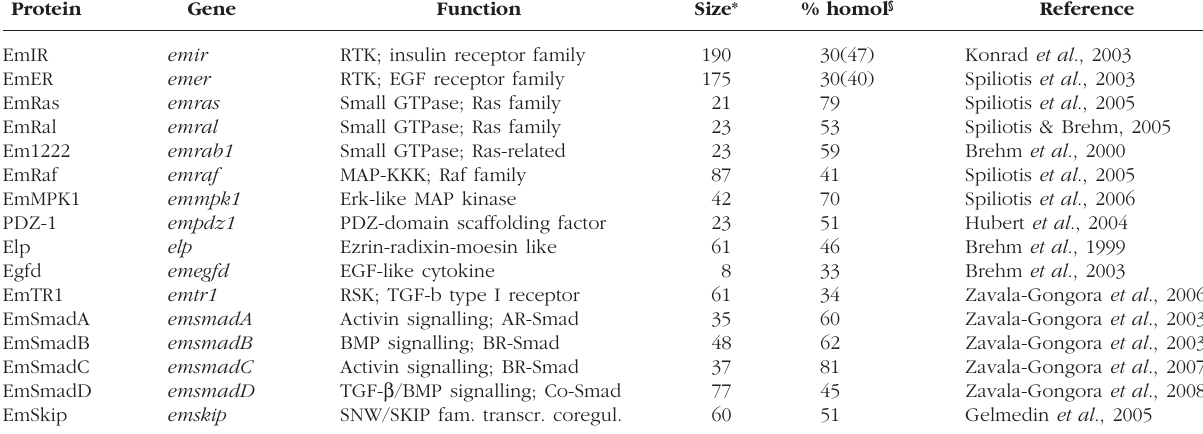
* protein size in kDa; § percent overall identity to corresponding human protein; value in brackets indicates identity in the tyrosine kinase domain. Table I. – E. multilocularis signalling